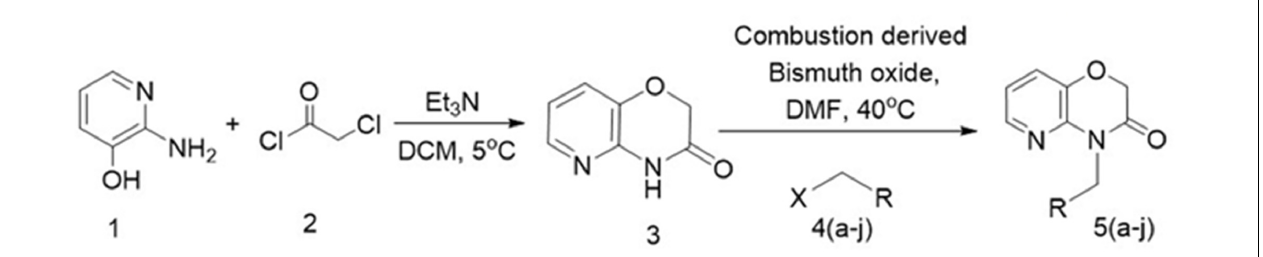
Frontiers in Pharmacology |